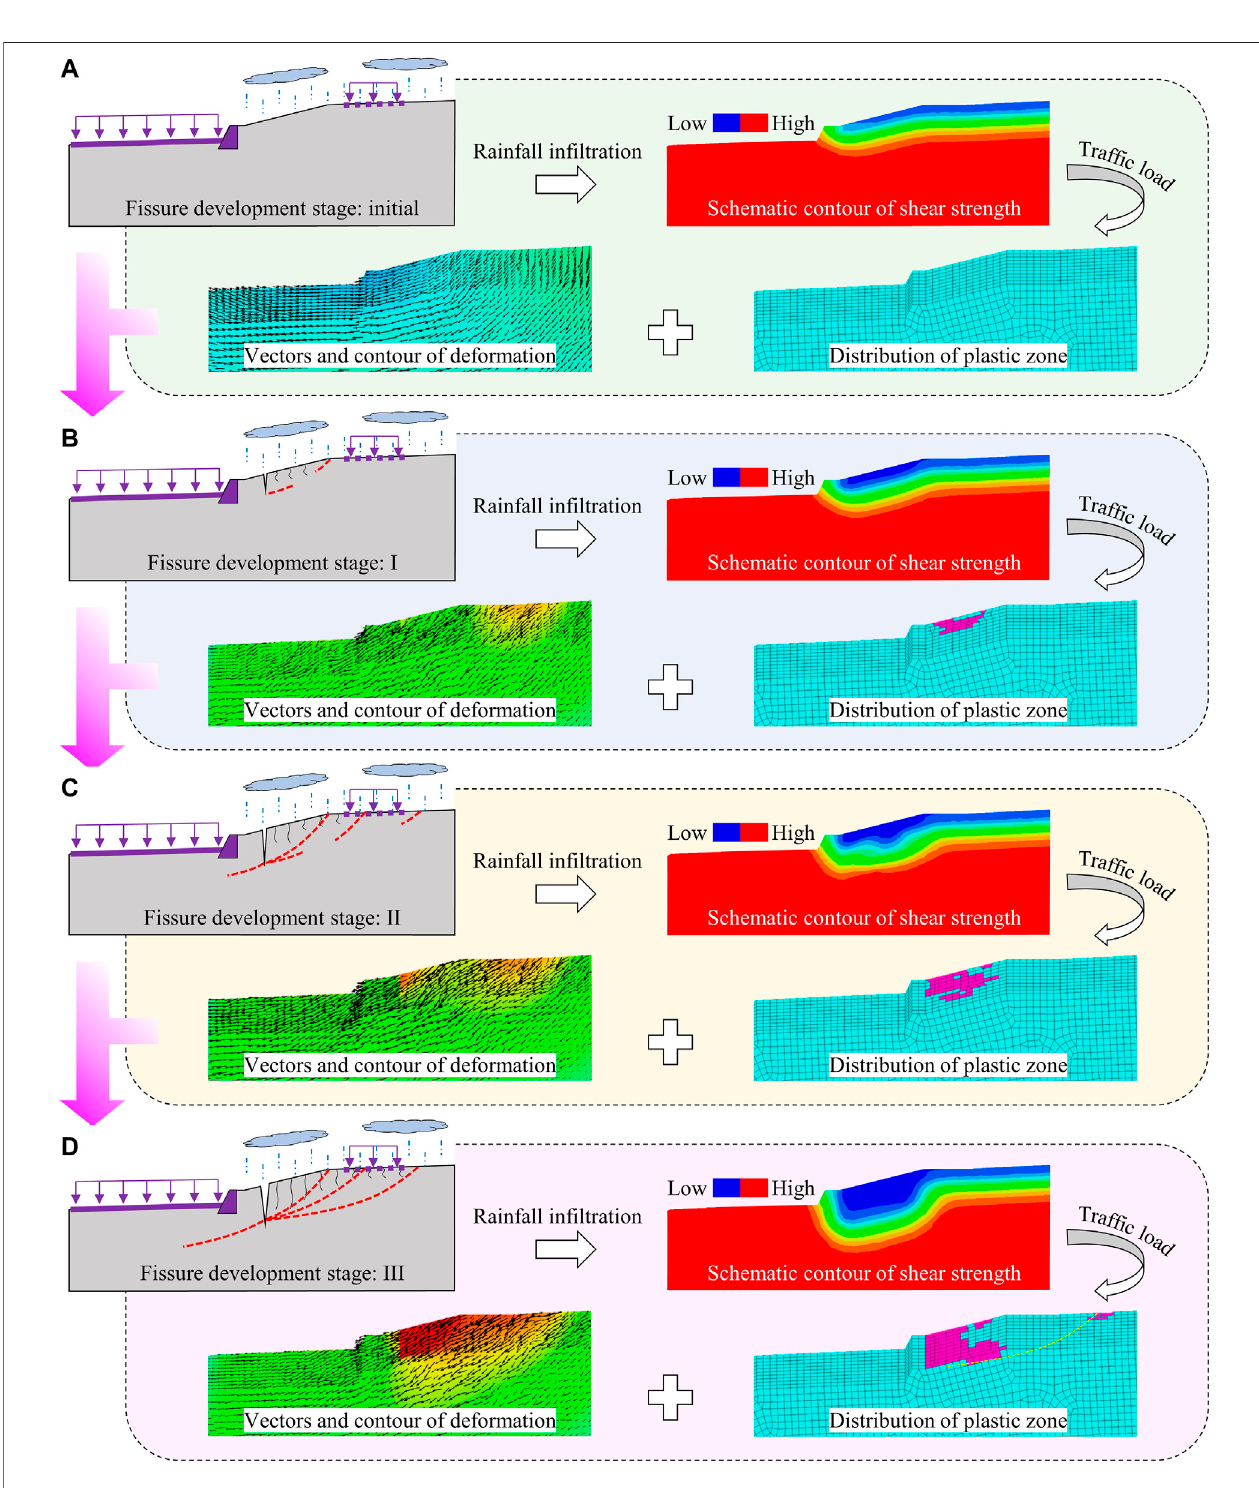
FIGURE 9 | Fissure-deformation development process of the slope under rainfall and traf fi c load: initial stage (A) , micro-crack penetration stage (B) , fi ssure propagation stage (C) and sliding surface formation stage (D) .